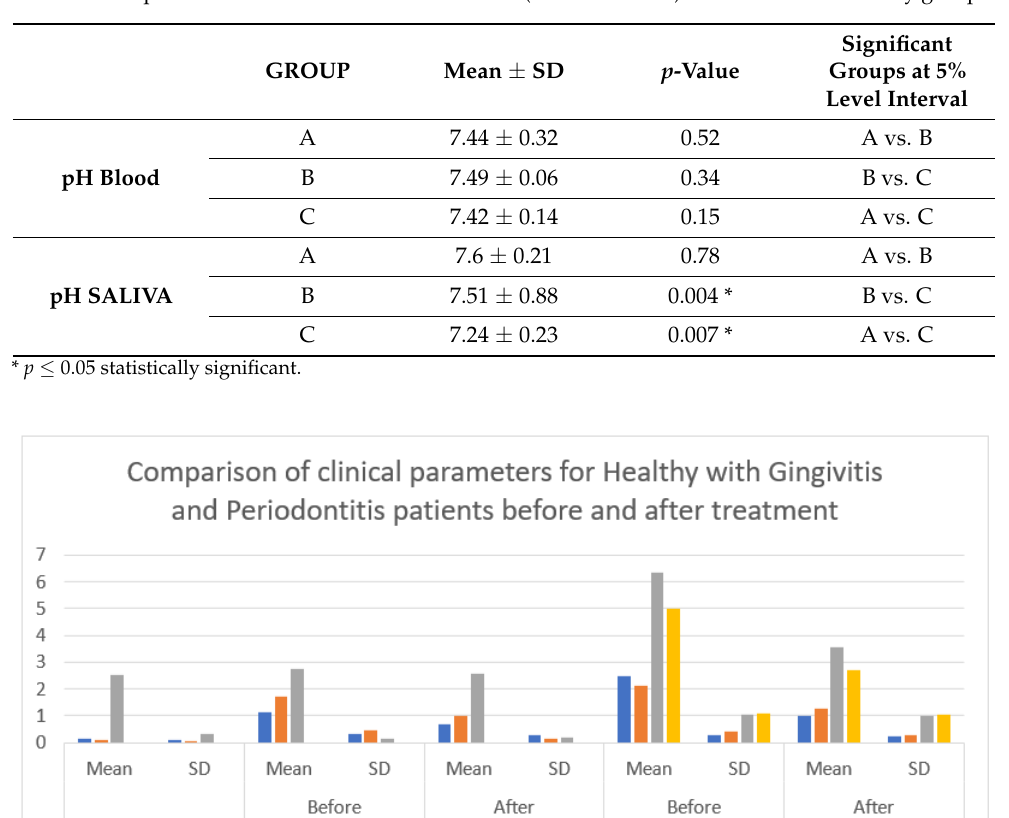
Table 4. Comparison of mean values of the variables (after treatment) between different study groups.